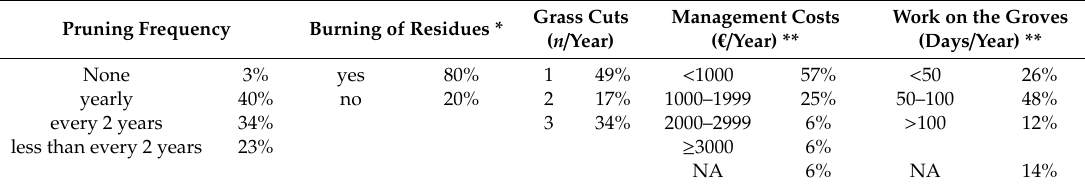
Table 8. Grove management intensity by the hobby farmer samples ( n = 35); % refers to the total per